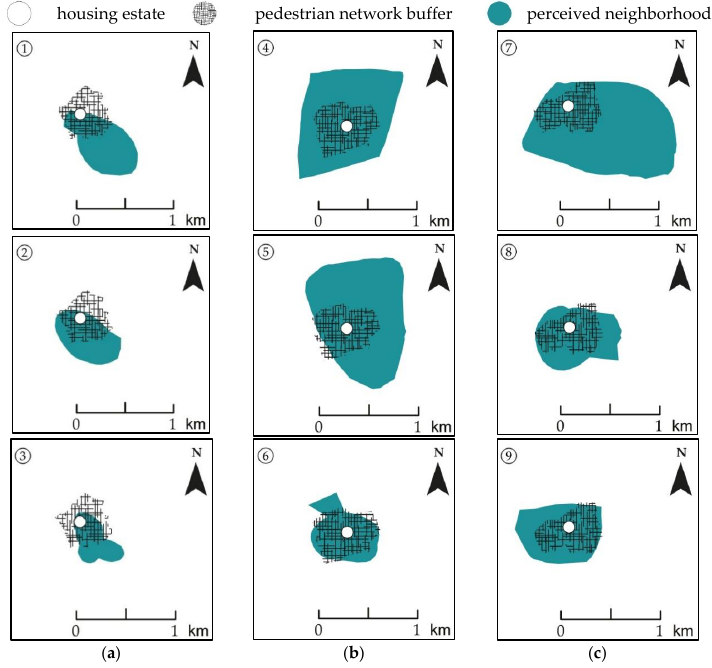
buffers (Figure 1: 4 (cid:13) – 9 (cid:13) ) and many also exceeded them in one or more directions (Figure 1: 4 (cid:13) , 5 (cid:13) , 7 (cid:13) ). For others, there was a partial overlap between perceived neighborhoods and home-centered buffers (Figure 1: 1 (cid:13) – 3 (cid:13) ) and some also appeared to be home-centered like the buffers (Figure 1: 3 (cid:13) , 6 (cid:13) , 9 (cid:13) ). (Figure 1: ③ , ⑥ , ⑨ ).